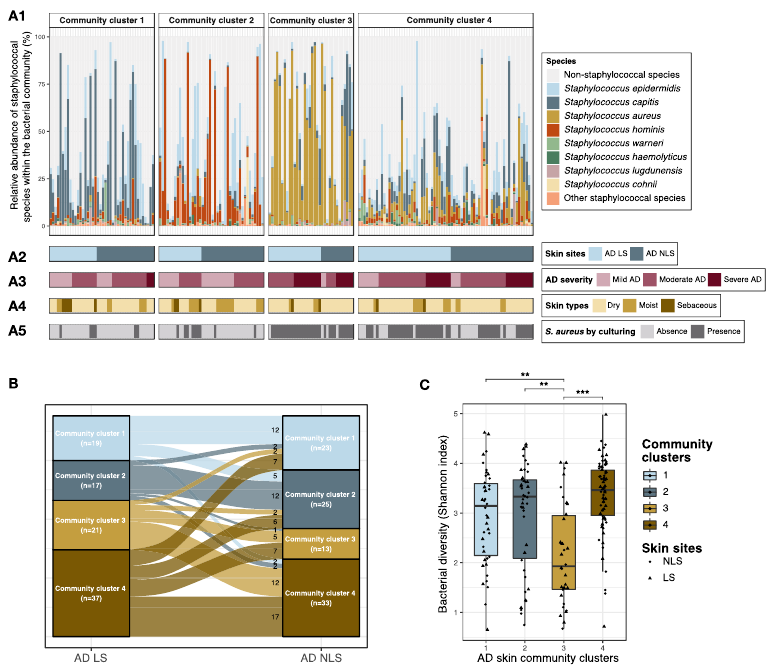
Figure 3. Staphylococcal communities on AD skin. Lesional and non-lesional skin from AD patients ( n = 94) were grouped into four distinct community clusters based on compositional similarities of staphylococcal species. ( A1 ) Bar plot showing the relative abundances of the eight most abundant staphylococcal species within the bacterial community. ( A2 ) Tile plot showing whether samples were collected from lesional or non-lesional skin. ( A3 ) Tile plot showing the AD severity of patients from whom the samples were collected. Mild AD: SCORAD < 25; Moderate AD: SCORAD 25–50; and Severe AD: SCORAD > 50. ( A4 ) Tile plot showing whether samples were collected from dry, moist, or sebaceous skin areas. ( A5 ) Tile plot showing S. aureus colonization status, defined by culturing. ( B ) Sankey diagram for intra-individual comparison of staphylococcal community cluster assignment of lesional and non-lesional skin. ( C ) Comparison of skin bacterial alpha diversity, measured by Shannon index, across the four defined staphylococcal community clusters. Lesional and non-lesional skin samples were visualized as triangles and dots, respectively, and boxplots represent the median and interquartile range (IQR) with whiskers extending to the minimum/maximum value, but no longer than 1.5 × IQR. Asterisks indicate statistical signif- icance: ** adj. p < 0.01, *** adj. p < 0.001. Abbreviations: AD: atopic dermatitis; LS: lesional skin; NLS: non-lesional skin.